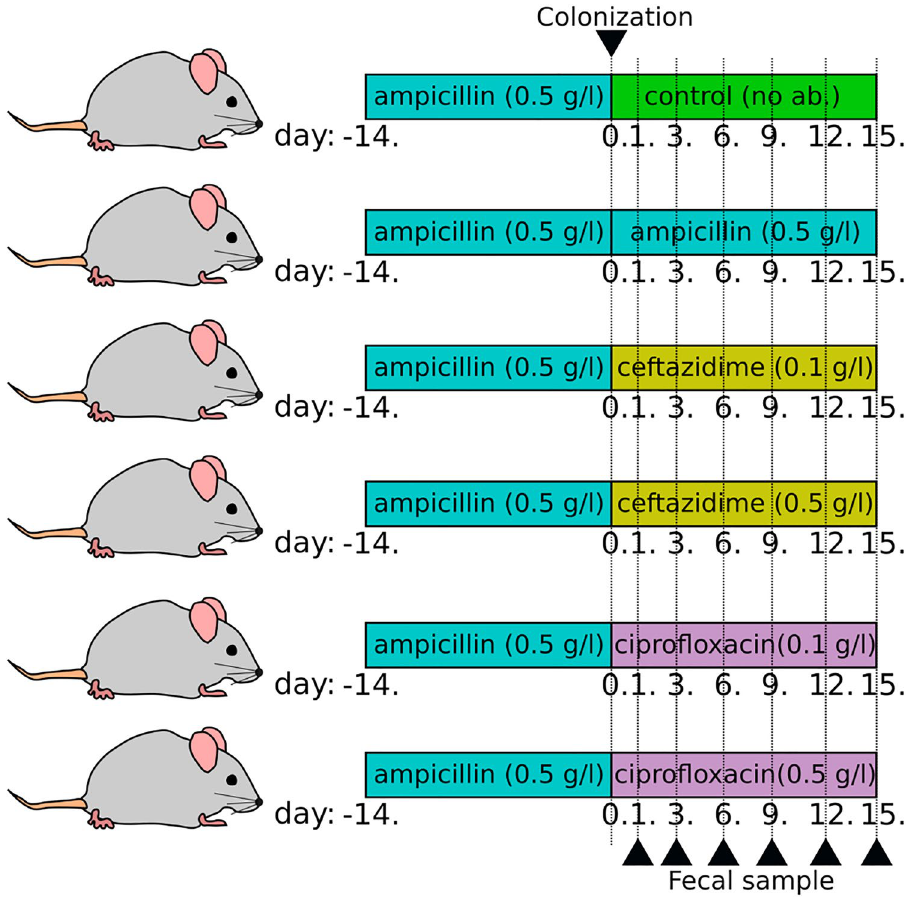
Figure 1. The colonization protocol used in our